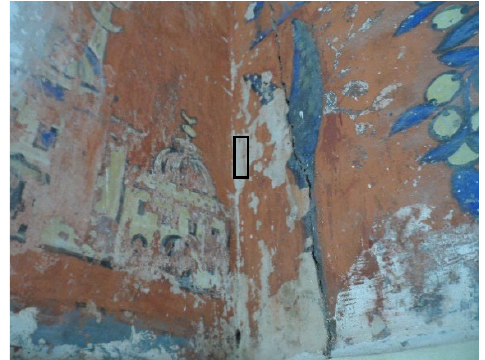
Figure 6. ROI (in rectangle) in the original RGB image.